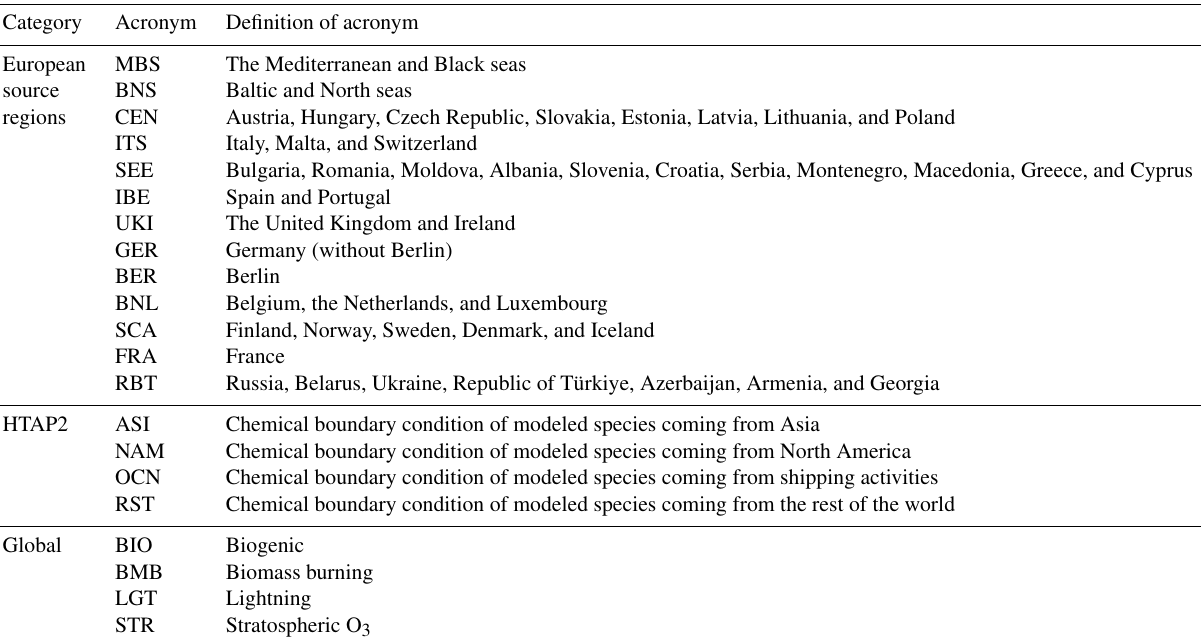
Table 1. List of tagged European source regions for the NO x tagging mechanism.